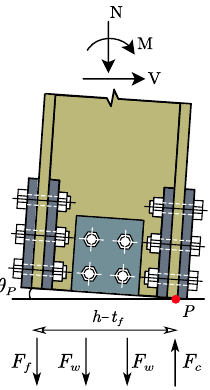
Figure 2. Details of the CPSFC.